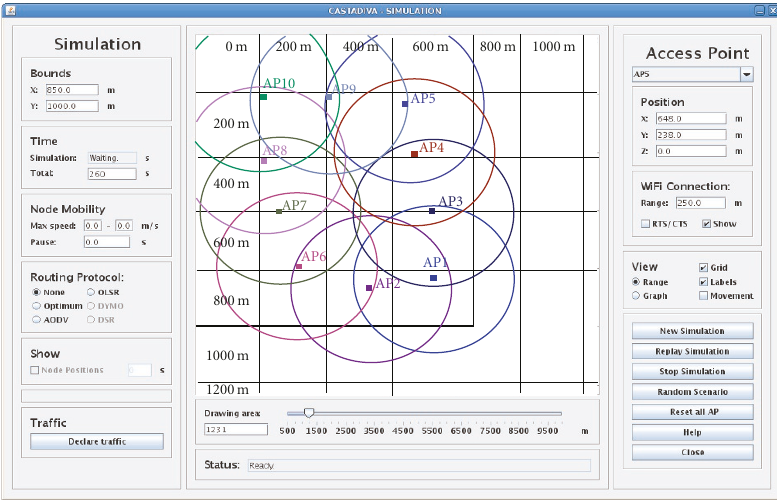
Figure 6: Scenario definition with Castadiva .